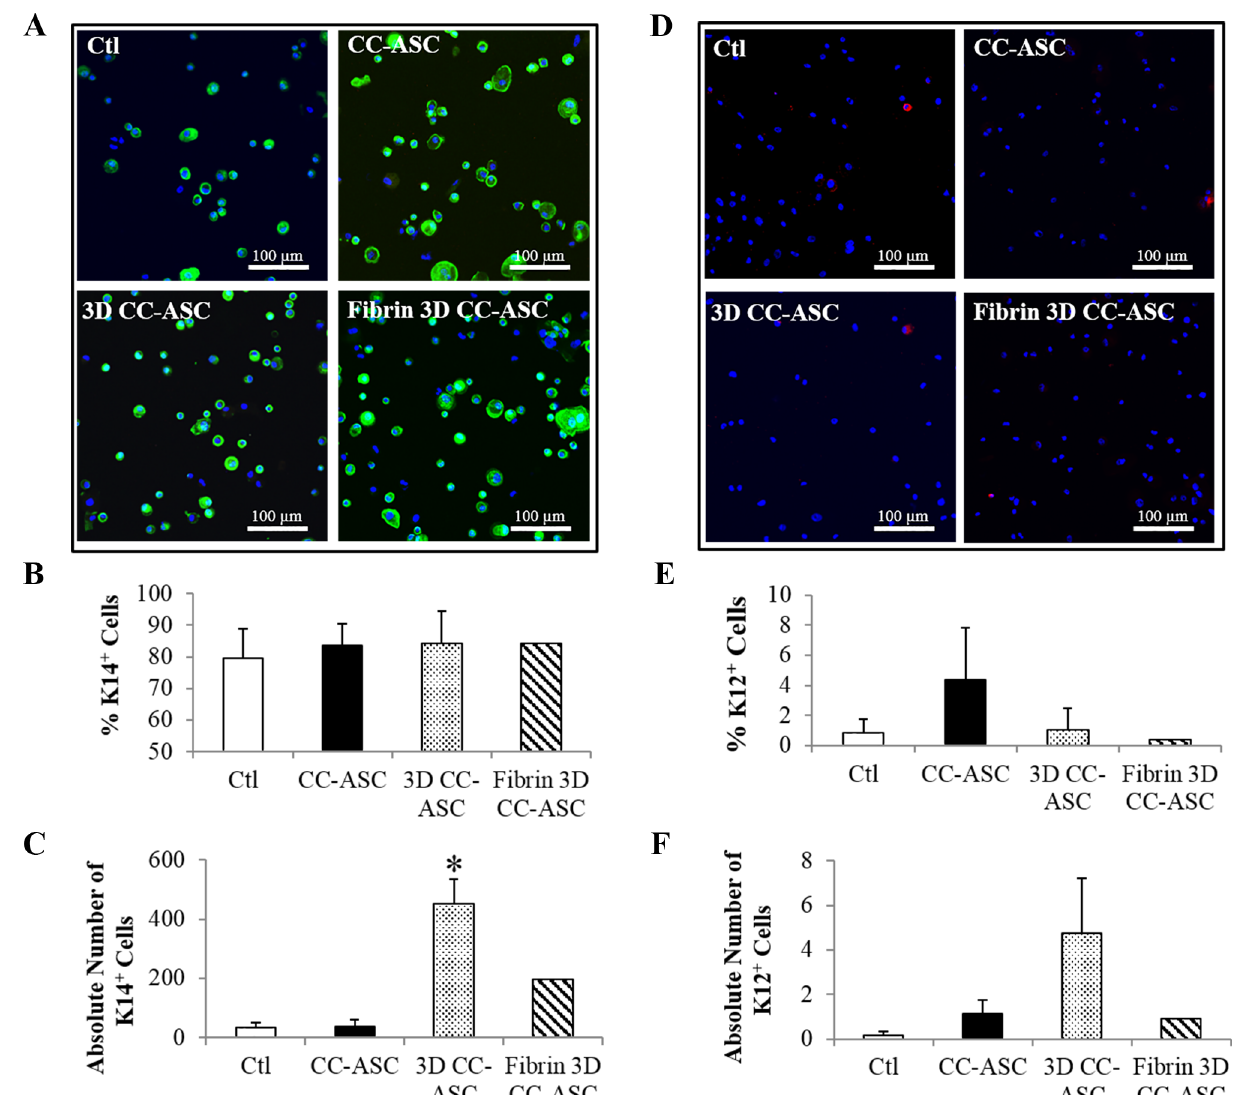
Fig 7. Expression of K14 and K12 in cultured LEC cell clusters with ASCs evaluated by immunocytochemistry. (A) Representative images showingthe expressionof K14 in culturedLECs. (B) The percentagesof K14 + cells in culturedLECs. (C) The absolutenumbersof K14 + cells in cultured LECs. (D) Representative images showingthe expressionof K12 in culturedLECs. (E) The percentagesof K12 + cells in culturedLECs. (F) The absolute numbers of K12 + cells in cultured LECs. The absolute numberof K14 + or K12 + cells = the percentage of K14 + or K12 + cells x (number of cells harvested/number of cells seeded). * : p < 0.05in comparisonwith results of control. Ctl: control. CC-ASC: cell clusters of LECs cultureddirectly on ASCs. 3D CC-ASC: cell clusters of LECs cultured on ASCs using the 3D method. Fibrin 3D CC-ASC: cell clusters of LECs culturedon ASCs using the fibrin 3D method. Scale bar = 100 μ m.